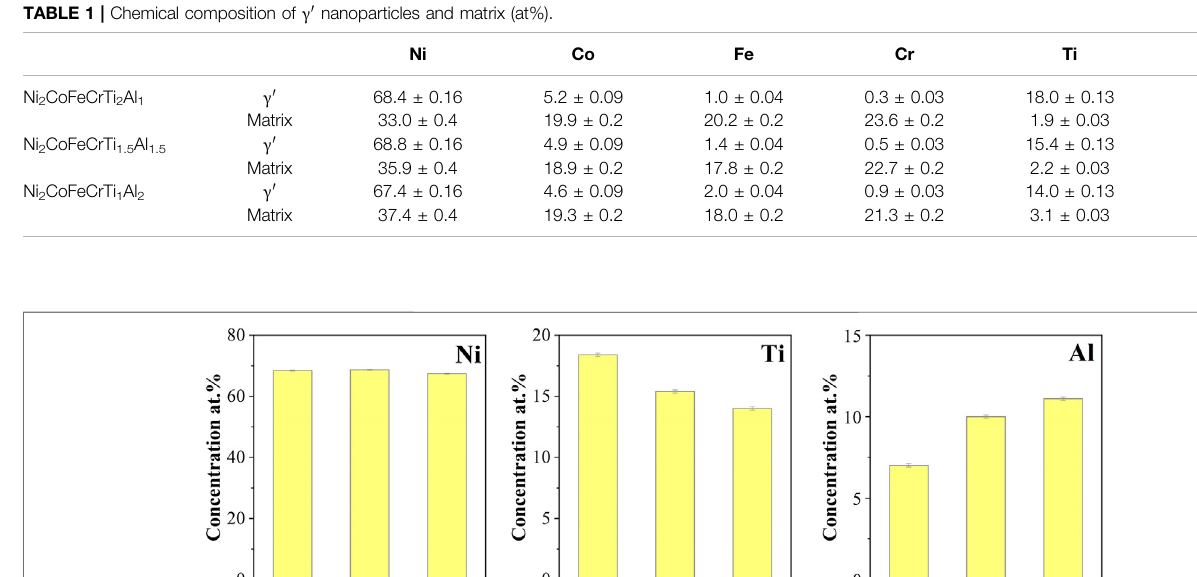
Frontiers in Materials |